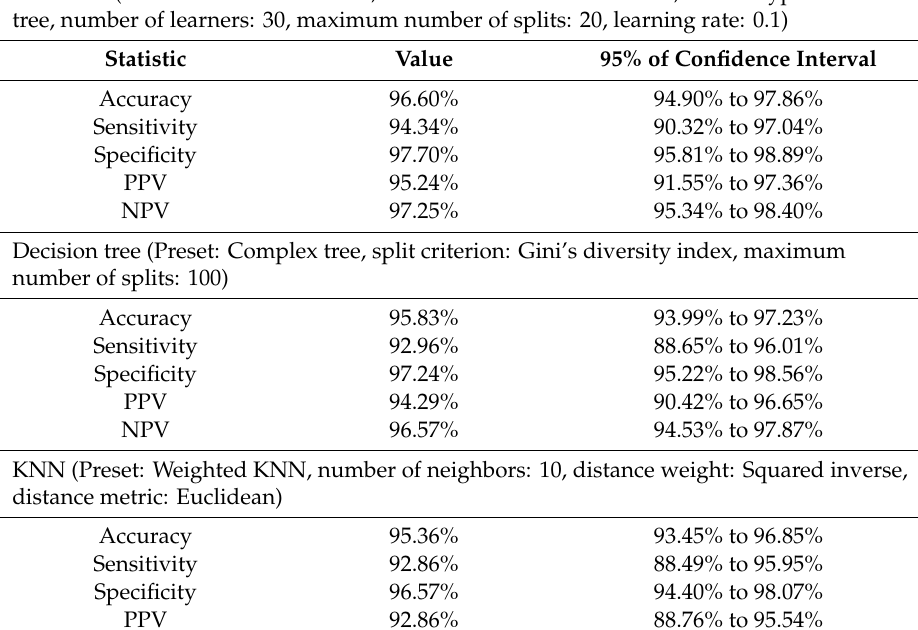
Table 7. Performance based on hybrid feature vector using breast ultrasound (BUS) images collected at the Baheya Hospital Egypt